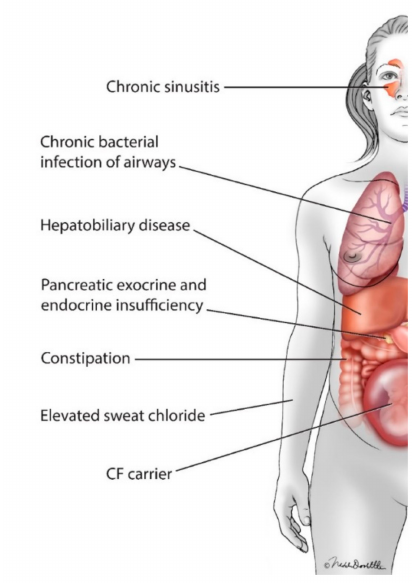
Figure 2. Women with cystic fibrosis (CF) who become pregnant and their infants may have increased risk because of the known complications that result from cystic fibrosis transmembrane conductance regulator (CFTR) dysfunction, including chronic respiratory infections, pancreatic insu ffi ciency and CF-related